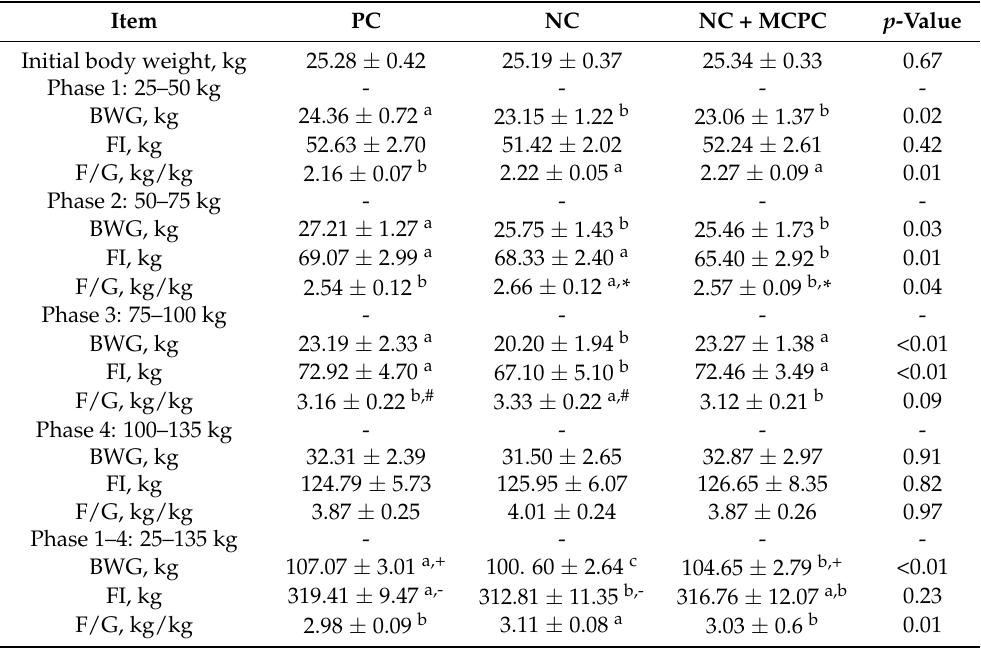
Table 3. Effect of multicarbohydrase and phytase complex on growth performance of growing- finishing pigs 1